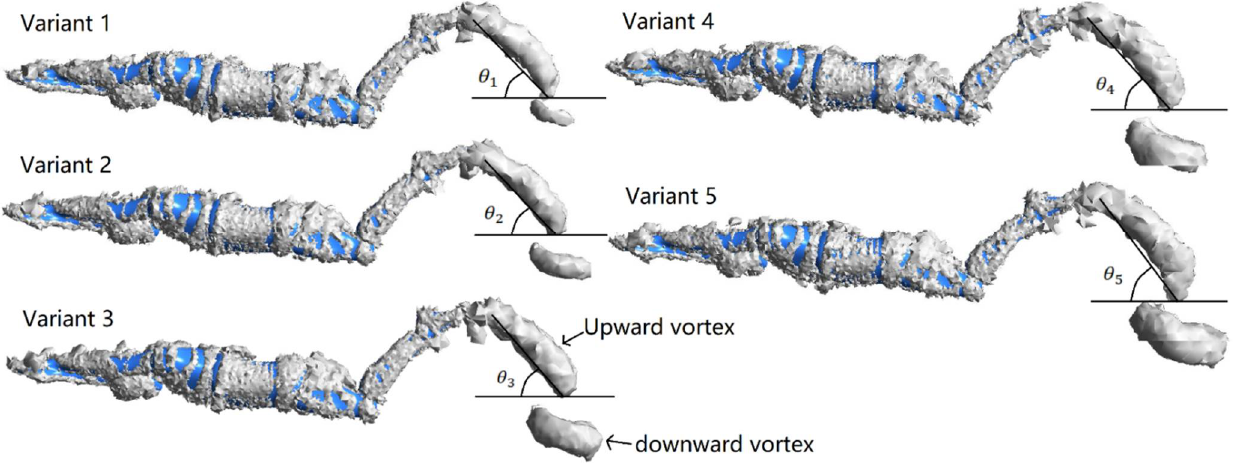
Figure 9. The influence of different trunk oscillations on the vortex structures near the feet at 0.43 T.